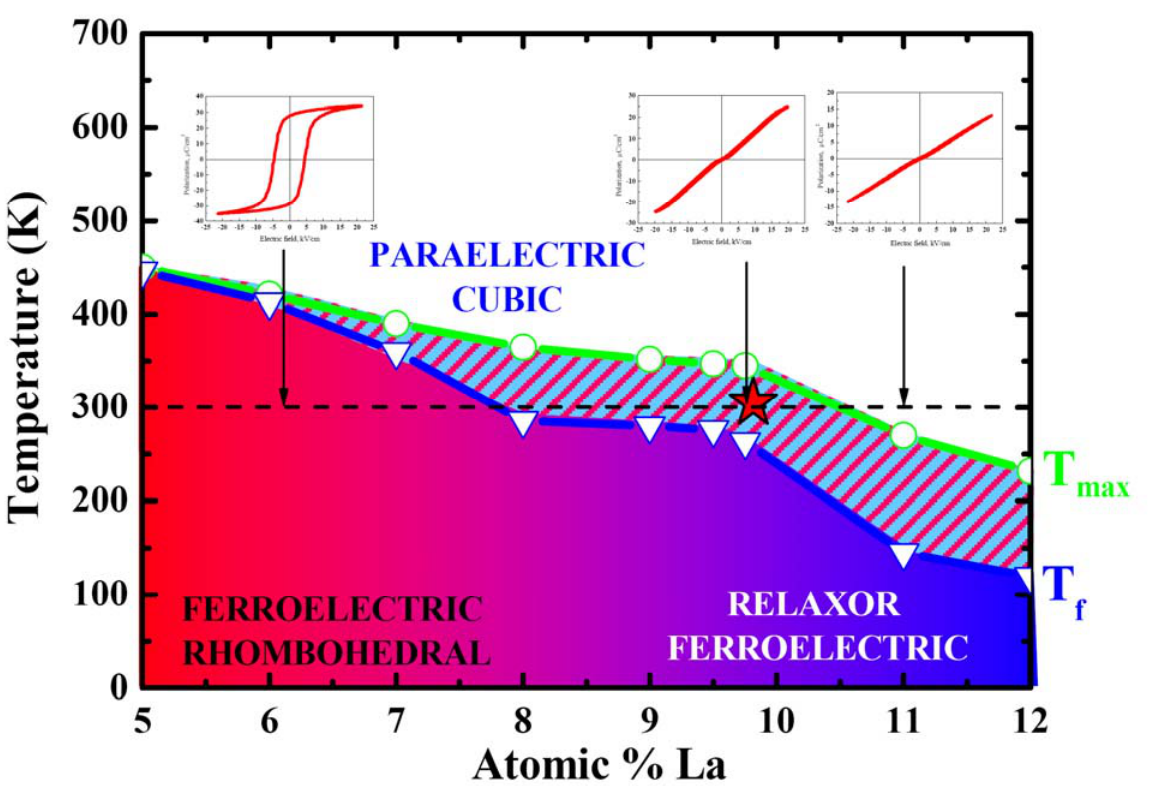
Figure 1. Phase diagram of the PLZT x/65/35 ceramics. P-E hysteresis loops of the